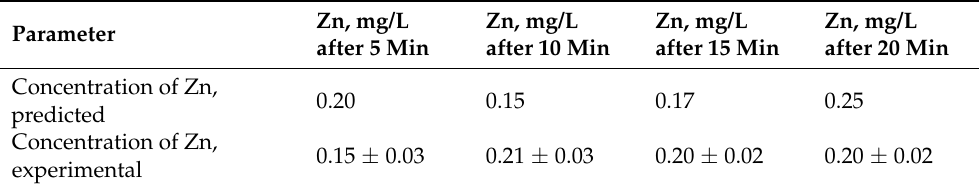
Table 8. The concentration of Zn in treated wastewater after RSM application in optimal conditions (pH = 10.75 ± 0.10, V Na 2 CS 3 dose = 0.043 mL/L and time = 5, 10, 15 and 20 min—experimental model verification).